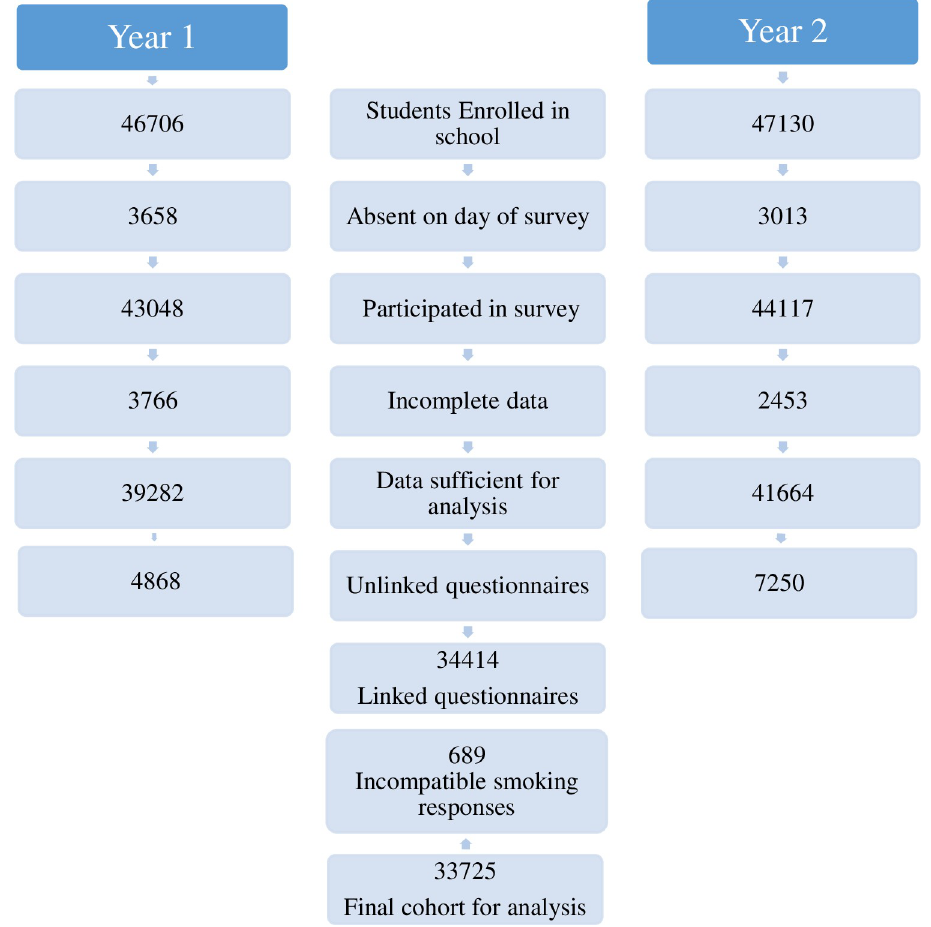
Fig 1. Flow chart of participant numbers in the two